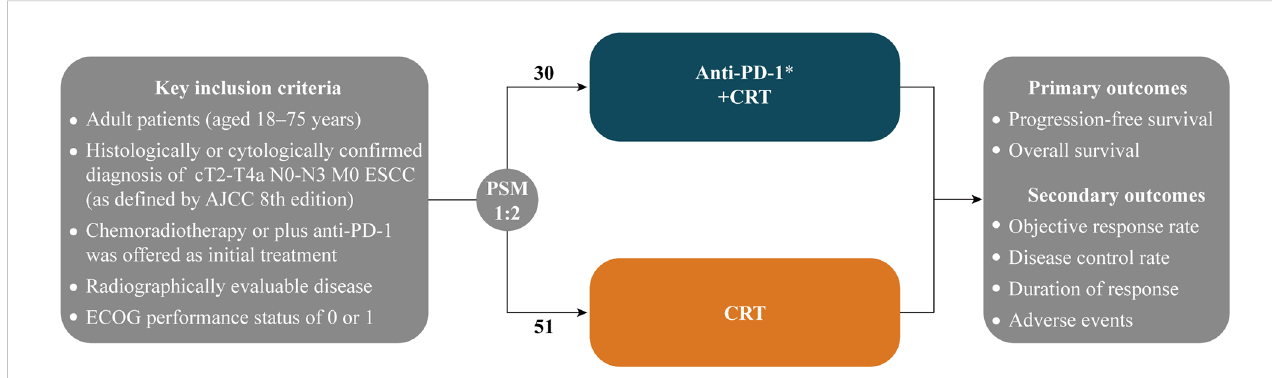
FIGURE 1 Maintain or until investigator-assessed disease progression, unacceptable toxicity, or withdrawal for other reasons; ESCC, Esophageal squamous cell carcinoma; AJCC, American Joint Committee on Cancer; ECOG, Eastern Cooperative Oncology Group; PSM: 1:2 nearest neighbor-matching with a caliper of 0.3; CRT,